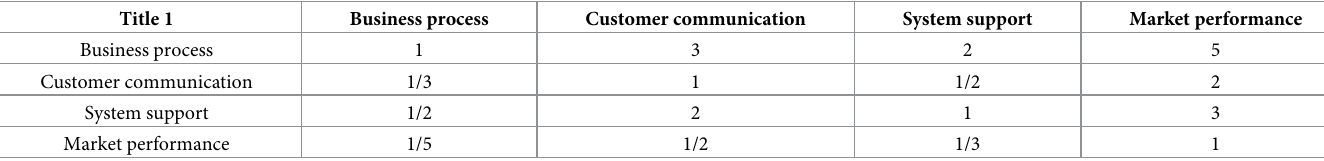
Table 4. Judgment matrix of level I indexes of CKMC